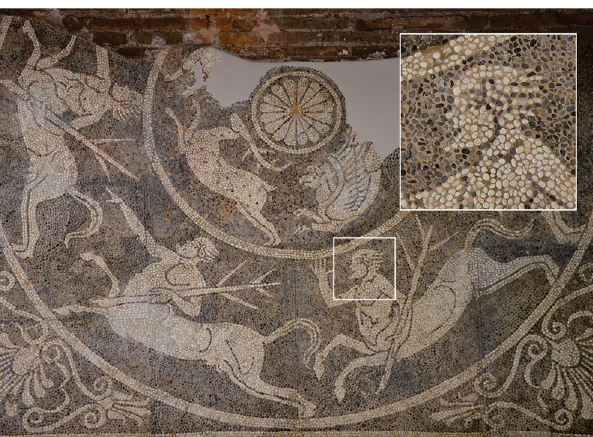
Fig. 1 Fragment of a pebble mosaic floor dating from the 4th century